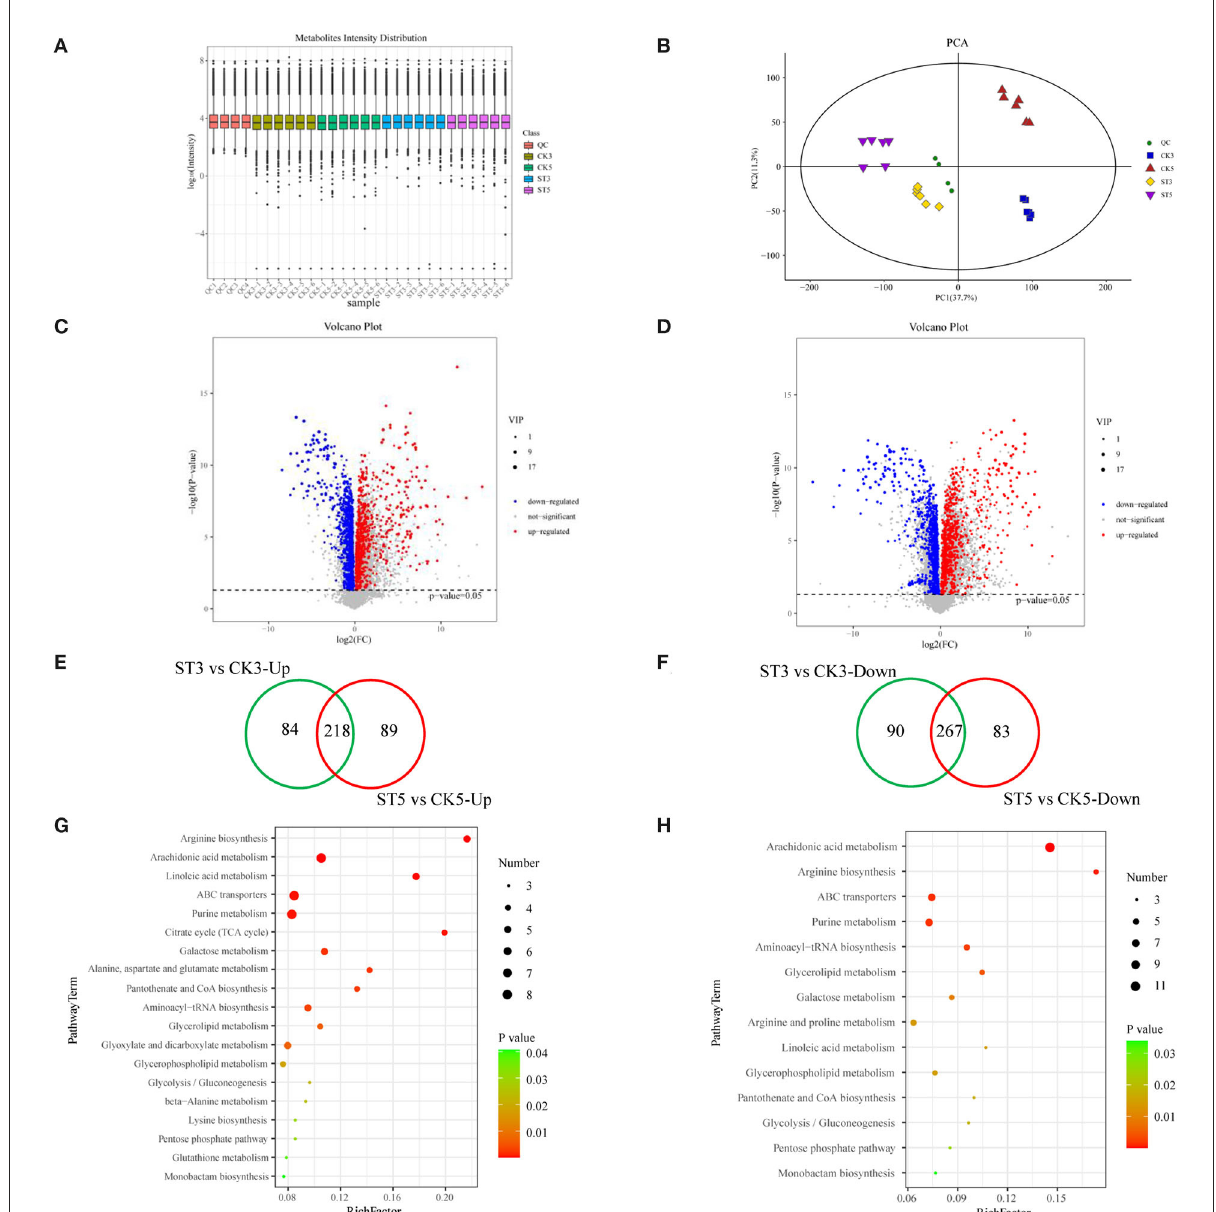
FIGURE4 Analysis of metabolites in rice shoots in the control (CK) and salt treatment (ST). (A) Overall expression level log 10 (intensity) of metabolites in rice seedlings in CK and ST. (B) Principal component analysis (PCA) of samples. Volcano plots for differentially abundant metabolites at (C) 3 and (D) 5 days after salt treatment. Venn diagrams of (E) up-regulated and (F) down-regulated metabolites between 3 and 5 days after salt treatment. Kyoto Encyclopedia of Genes and Genomes (KEGG) analysis of differentially abundant metabolites at (G) 3 and (H) 5 days after salt